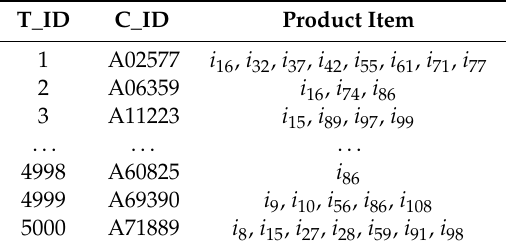
Table 2. Simulated purchase dataset.